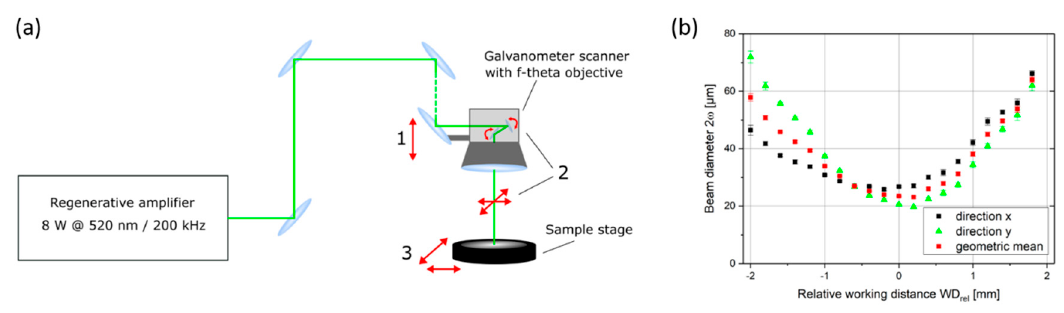
Figure 1. ( a ) Sketch of the beam path in the LMS, showing the three different possibilities of movement: (1) adjusting of working distance d , (2) beam scanning in x and y -direction by galvanometer scanner, (3) lateral movement of sample stage. ( b ) Beam characteristics, revealing different focus positions and beam diameters for the two main axes of the elliptical beam